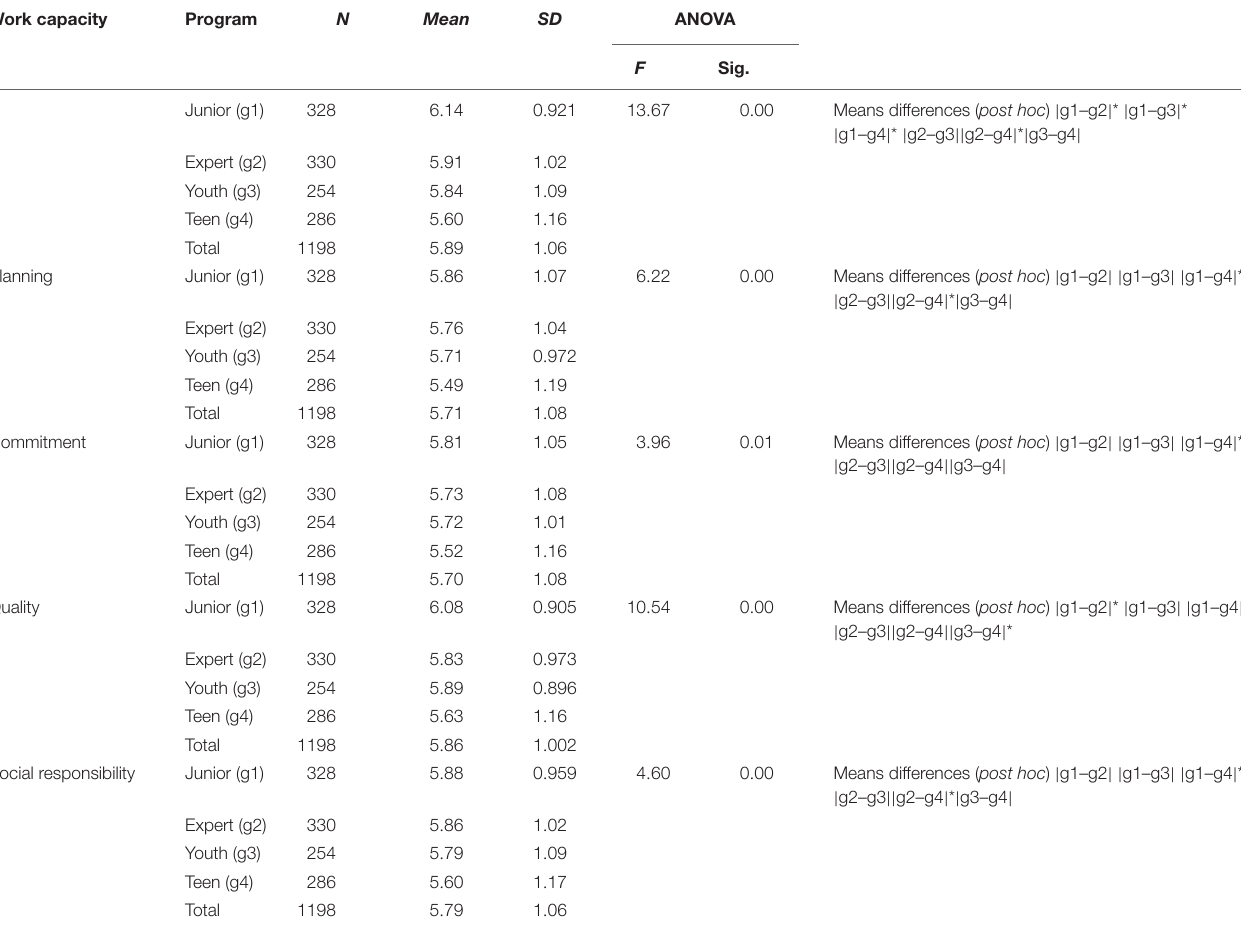
TABLE 4 | Students’ process and results competencies among four programs (Anova and post hoc ). Work